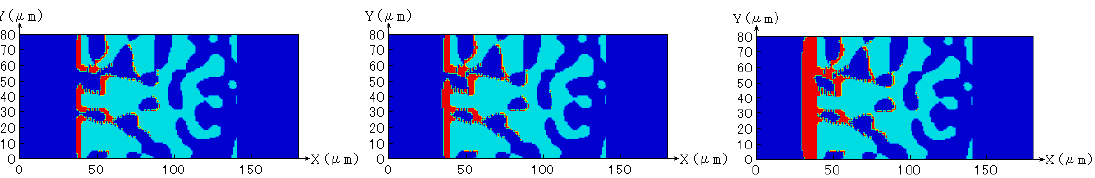
Figure 8. Three-dimensional soot layer at t = 15 s ( left ); 20 s ( middle ); 35 s ( right ) in case of Filter 1.